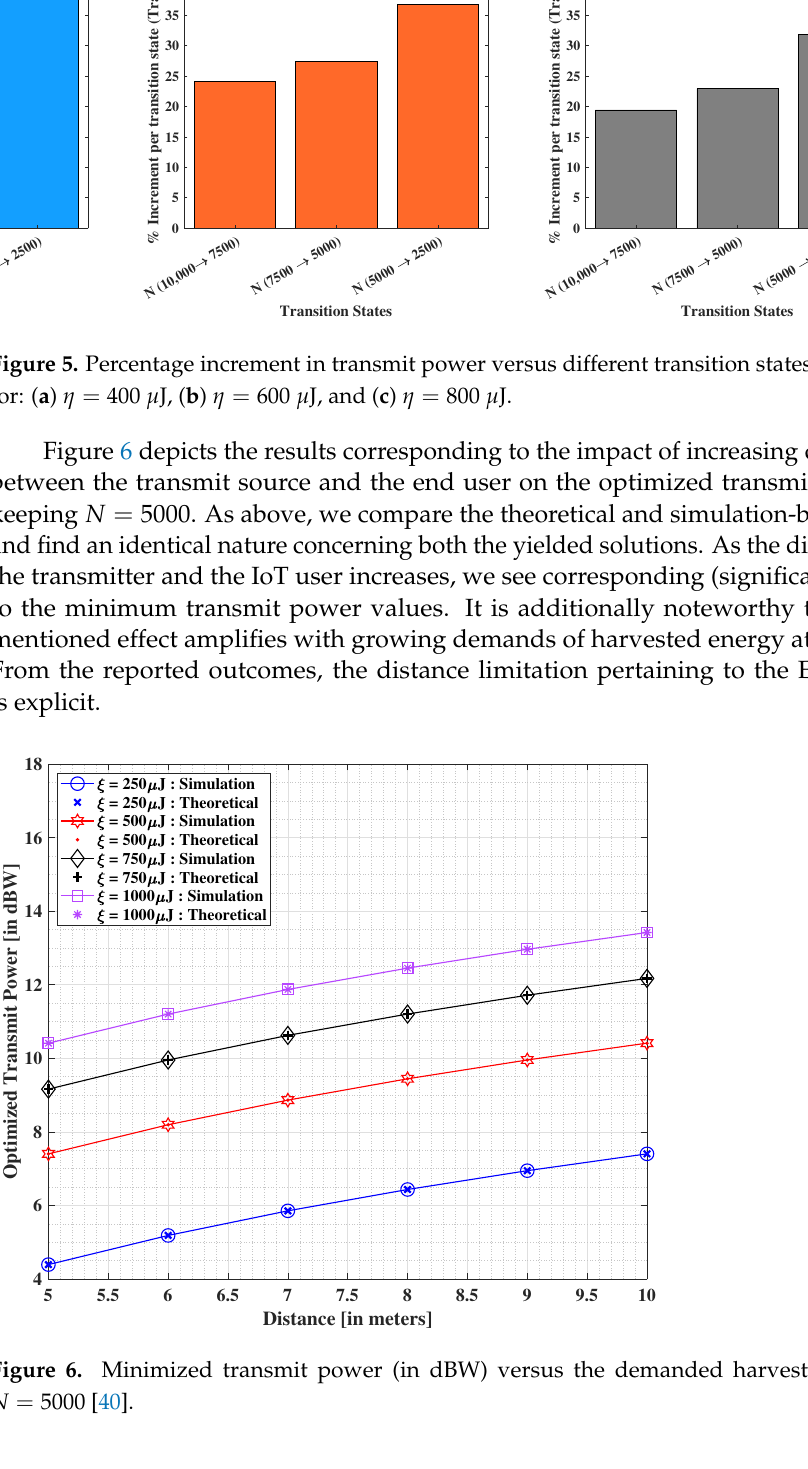
percentage increment in the transmit power for various transiting states of N . The escalation manner) is noteworthy for each of the cases, as shown. The overall results imply the non-linear incremental relationship of the transmit power with the number of RF-EH ICs, for increasing values of harvested energy demands.